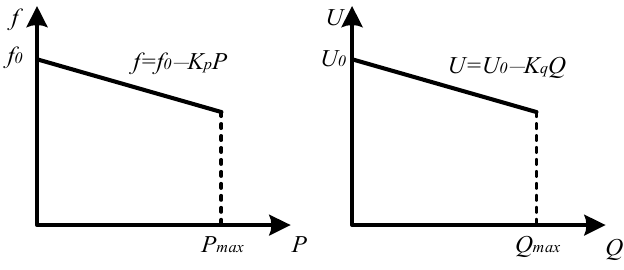
Figure 7. Parallel system droop characteristic curve